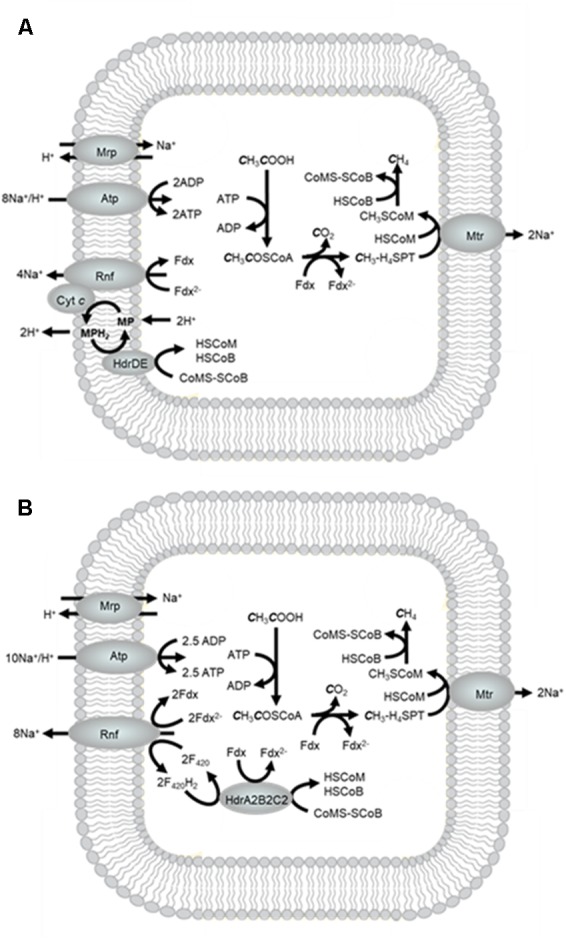
Acetotrophic pathway of Methanosarcina acetivorans. (A) Pathway based on the current biochemical understanding of electron transport. (B) Pathway showing electron transport based on the postulated role for FBEB by HdrA2B2C2 (Buckel and Thauer, 2018a).